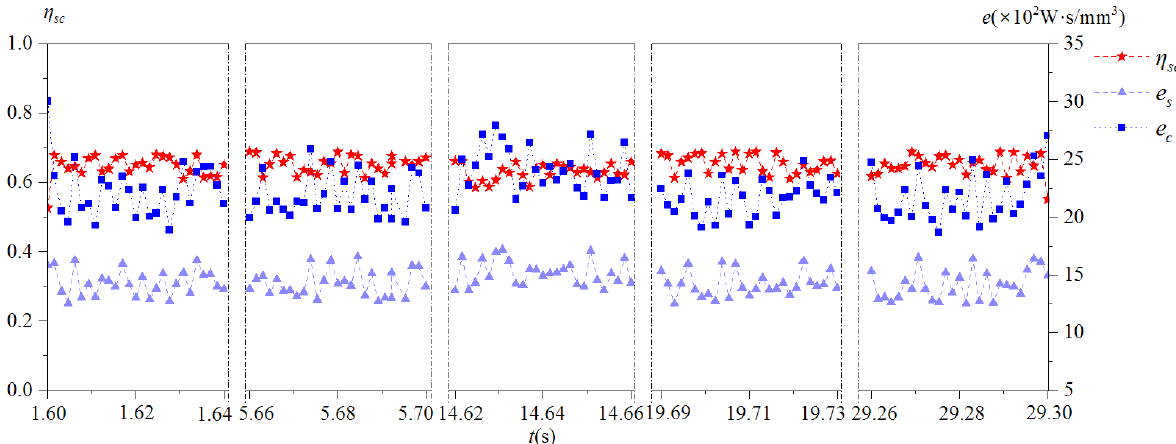
Figure 17. Cutting energy efficiency of milling cutter.